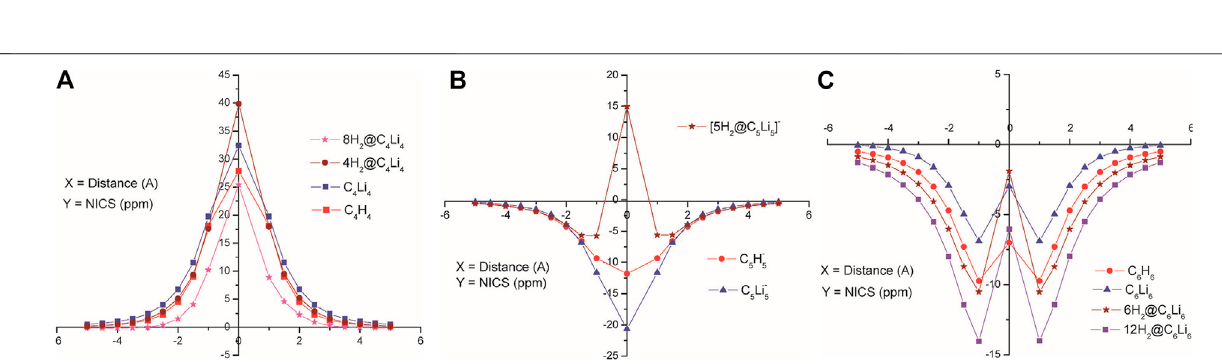
Frontiers in Energy Research |